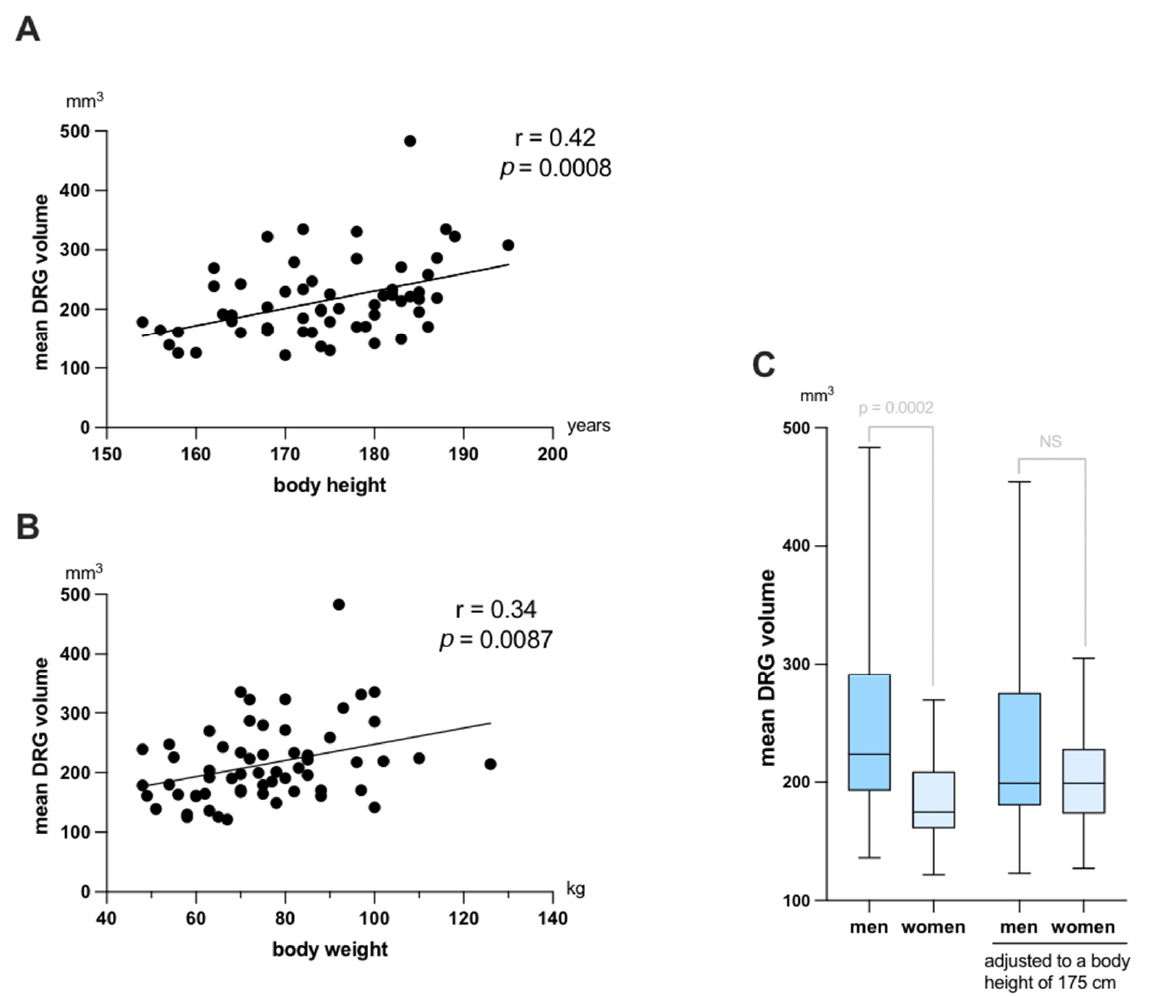
Figure 4. Correlation analyses of dorsal root ganglia (DRG) volume (mean of L3-S1) with the demographic variables ( A ) body height and ( B ) body weight. r = Pearson correlation coefficient. ( C ) Box-and-whisker plot of mean DRG volume in men and women as measured (left plots) and after correction to a body height of 175 cm (right plots) by linear regression. Median values are indicated by the horizontal line. Box length shows interquartile range, whereas whiskers represent range of data. NS = non-significant.